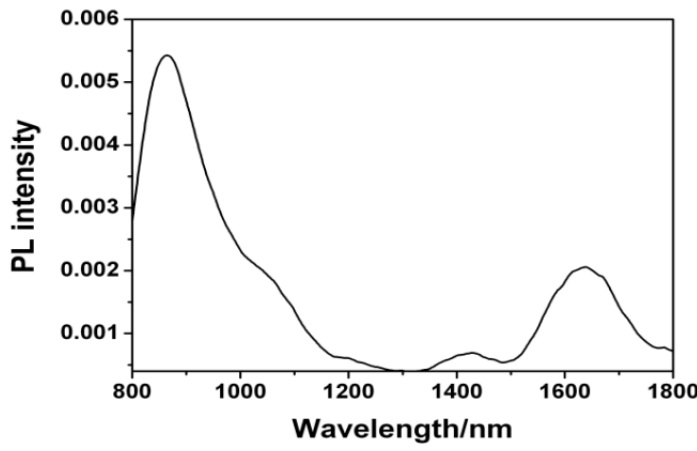
Figure 5. Emission spectrum of 1a at room